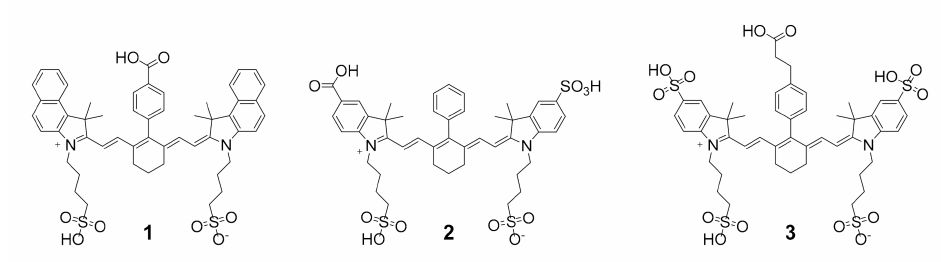
Figure 2. Structures of the NIR cyanine dyes used in this study: LS277 ( 1 ), CK002 ( 2 ) and SK015 ( 3